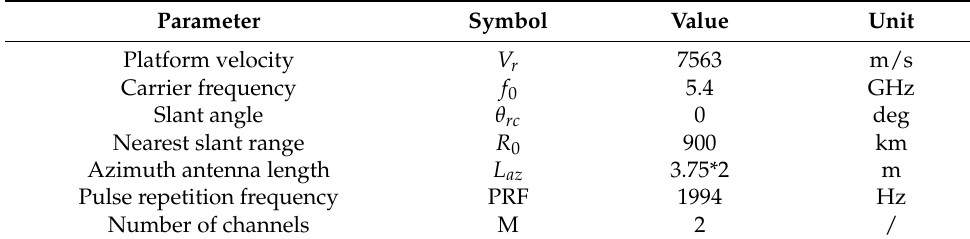
Table 7. GF-3 system parameters.